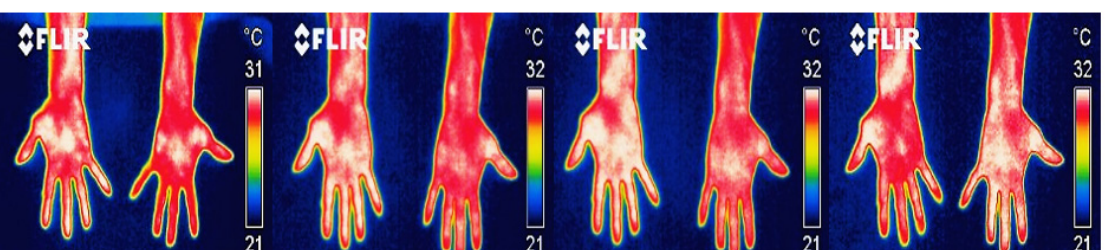
Figure 5. Example of thermogram taken from the front area of the palm at the times 5 ′ , 10 ′ , 15 ′ , and 20 ′ .